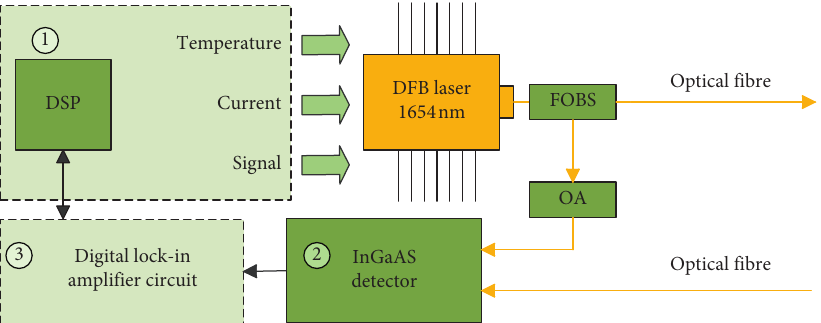
Figure 2: Schematic of the TDLAS-based gas detection system using the DFB laser at 1654nm.